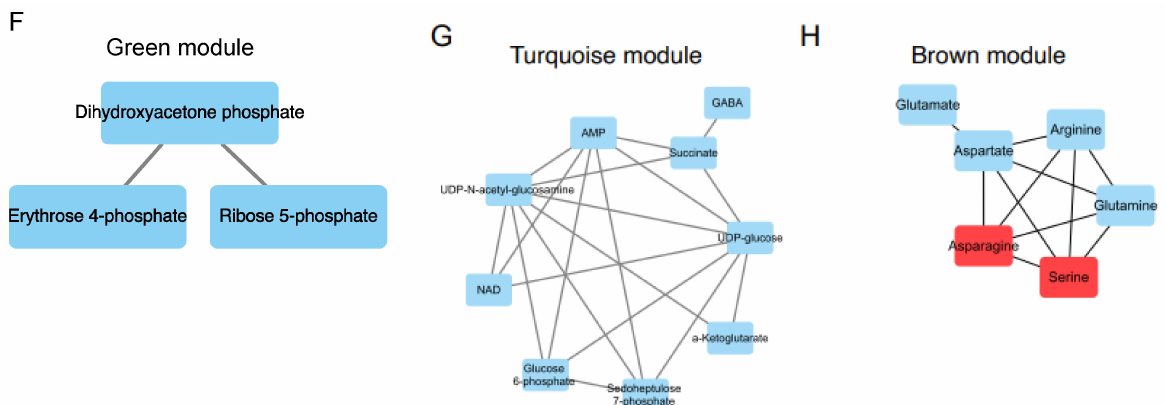
Figure 4. The transcriptomics signatures associated with folate-sensitive and stage-responsive tumour metabolomics markers. By tertile tumour folate stratification, transcript levels of regulatory enzymes and nutrient transporters involving ( A ) lactate metabolism, ( B ) glutamine metabolism, and ( C ) serine and folate cycle metabolism in pair NSCLCs were analysed by qPCR. Glyceraldehyde 3-phosphate dehydrogenase (GAPDH) was used as reference gene. Variables without common letter differed at p < 0.05. ( D ) Differential expression gene (DEGs) stratified by advance stage and altered tumour folate. Data are presented as delta delta Ct for relative expression as opposed to the paired lungs. Means for variables without common letter differed at p < 0.05 by One-way ANOVA (analysis of covariance) following a Duncan test or a student t test. * p < 0.05; ** p < 0.01. ( E ) Metabolite modulates associated with DEGs clustering by weighted gene co-expression network analysis (WGCNA). Each row stands for a module metabolite (MM), and each column represents DEGs. Each long square contains the correlation coefficient with p value in parenthesis. Differential enriched metabolites network in folate-associated ( F ) green, ( G ) turquoise, and ( H ) brown module. Red block represents the hub